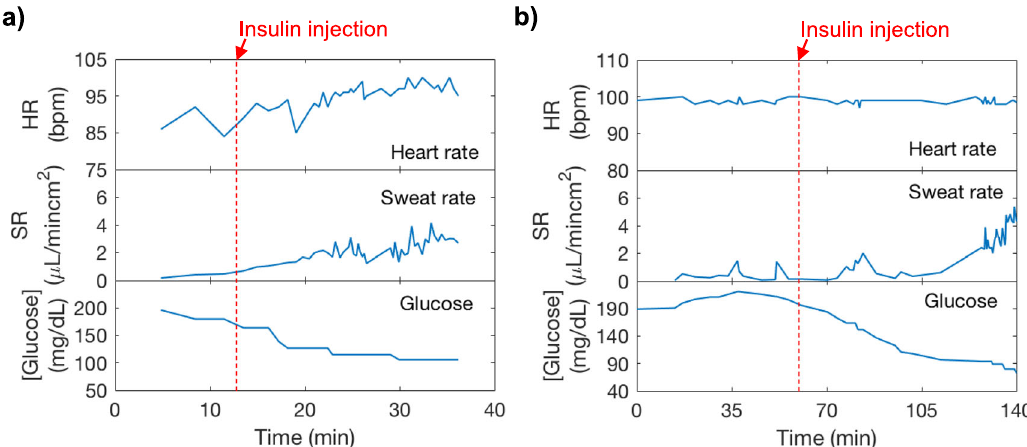
Fig. 6 In situ sweat analysis for hypoglycemia-induced sweat analysis. Sweat secretion rate was measured along with heart rate and ISF glucose levels of a diabetic subject. Subject had insulin injection to lower glucose levels in ( a ) trial 1 and ( b ) trial 2.